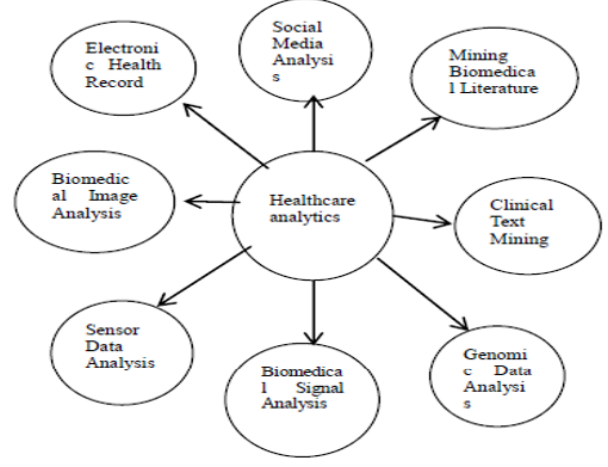
Fig.1. Healthcare analytics Data